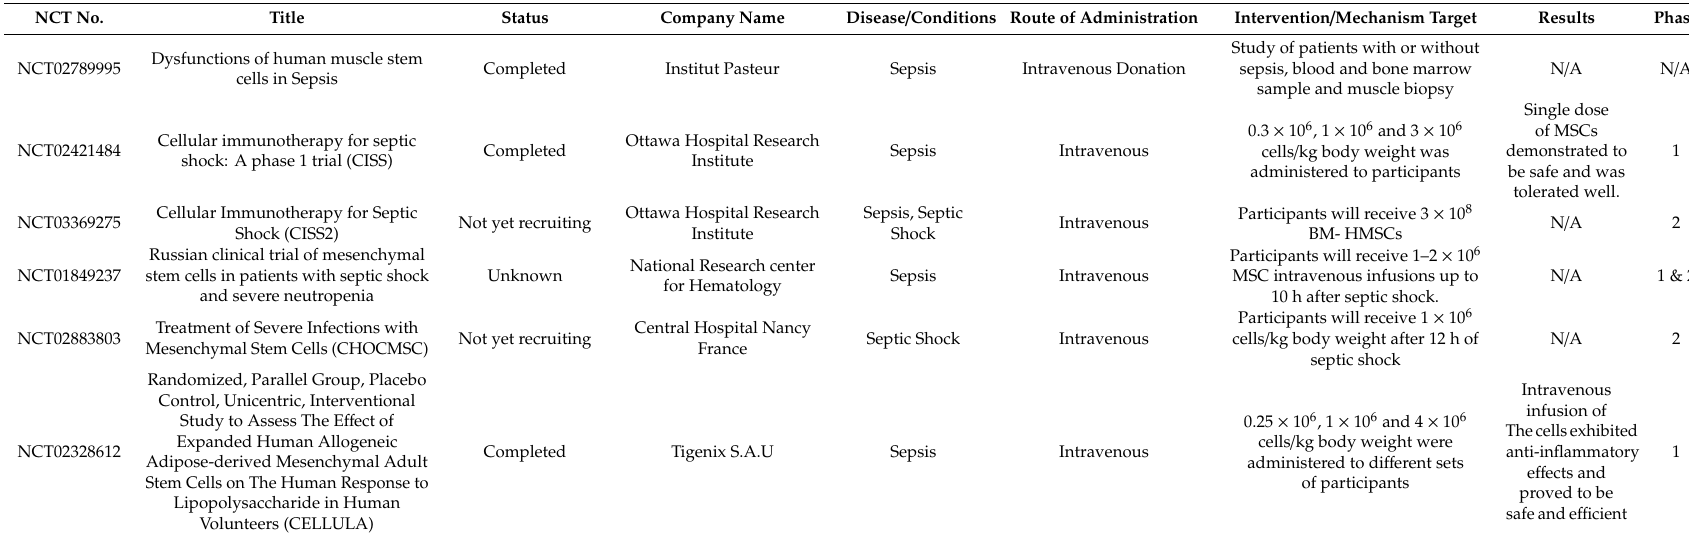
Table 2. MSC-based therapy clinical trials for